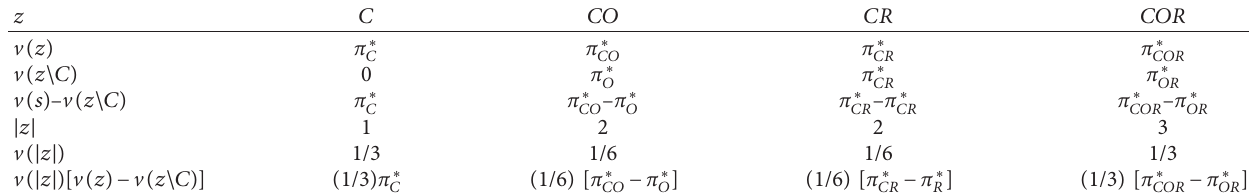
Table 1: Calculation of Shapley value of cold chain agro-products supplier.